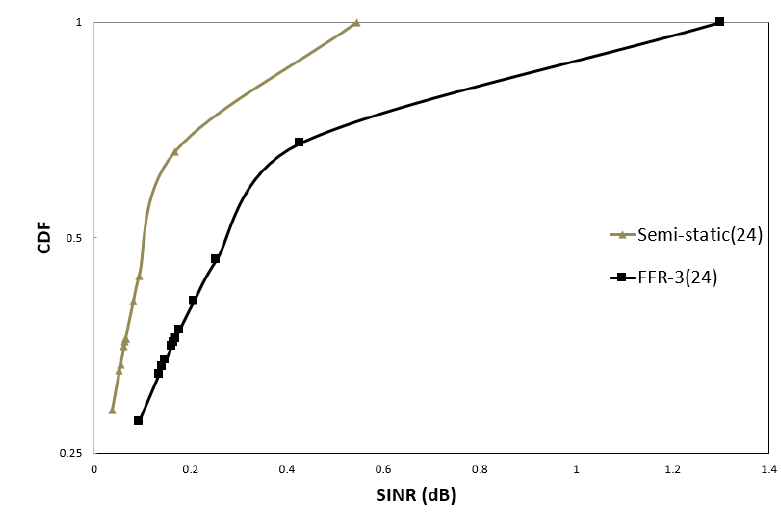
Figure 13. CDF of sensor SINR in cellular link (D2D Tx power = 25 dBm).